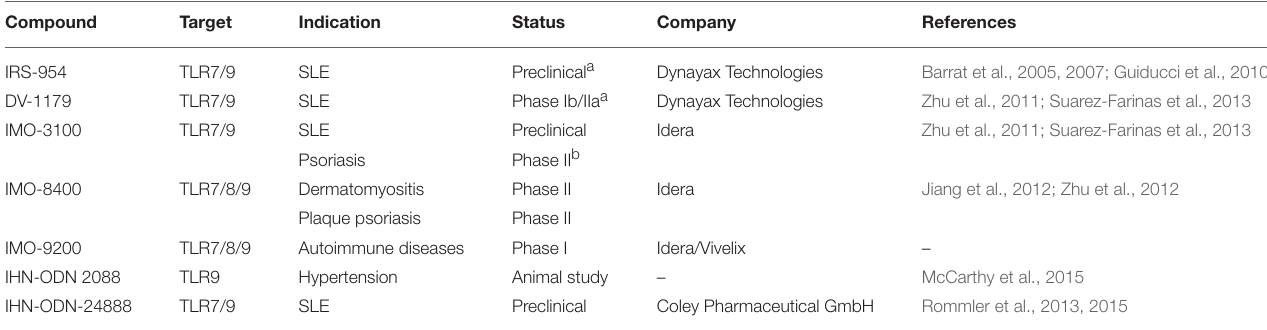
TABLE 4 | The development status of TLR antagonists/inhibitors: class of oligonucleotides.